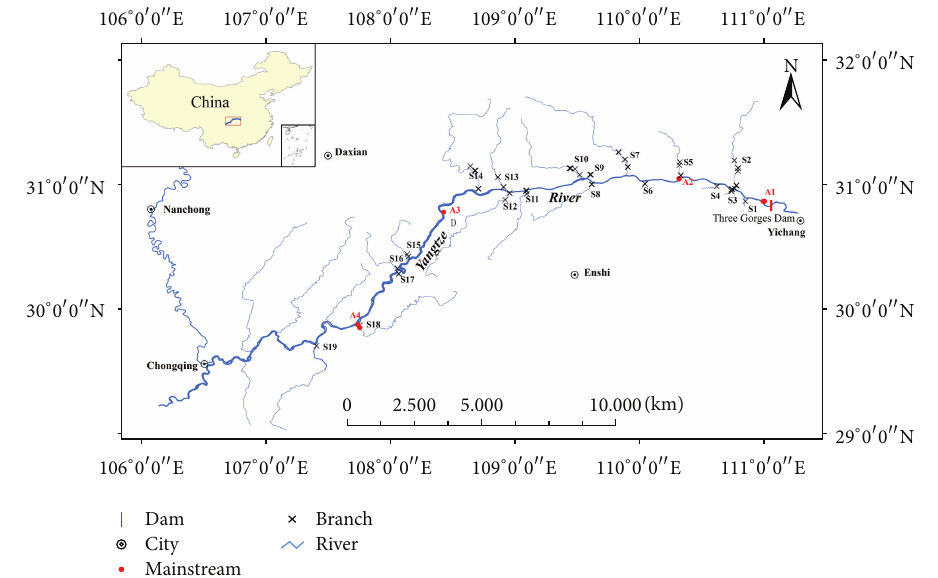
Figure 1: Location of sampling sites in TGR,